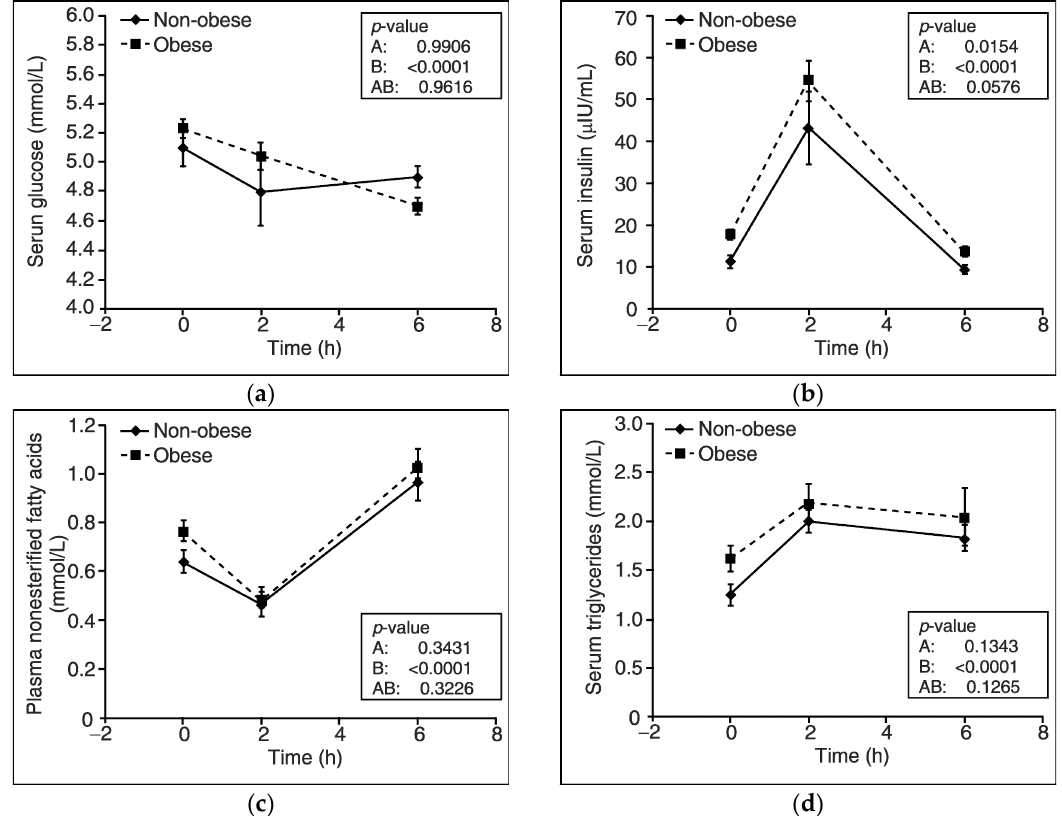
Figure 1. Changes in blood levels of glucose, insulin, nonesterified fatty acids, and triglycerides during a high fat mixed meal tolerance test in obese ( n = 70) and non-obese subjects ( n = 24). ( a ) Glucose concentration in serum. ( b ) Insulin concentration in serum. ( c ) Nonesterified fatty acids concentration in plasma. ( d ) Triglycerides concentration in serum. Values are presented as means ± SEM. Statistics: Analyses were performed with repeated-measures by ANOVA and denote differences between non-obese and obese participants (A), differences over time (B), and differences owing to an interaction between group and time (AB).